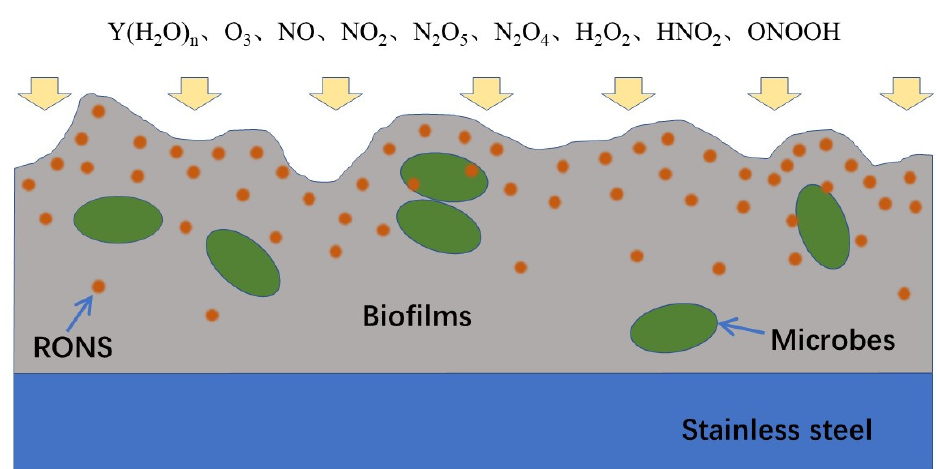
Figure 9. Mechanism for the inactivation of microbes in the biofilms by humidified air plasma. The humidified air plasma generates the long-lived RONS in the gas phase, such as Y(H 2 O) n , O 3 , NO, NO 2 , N 2 O 5 , N 2 O 4 , H 2 O 2 , and HNO 2 . These long-lived RONS diffuse into the biofilms and react with